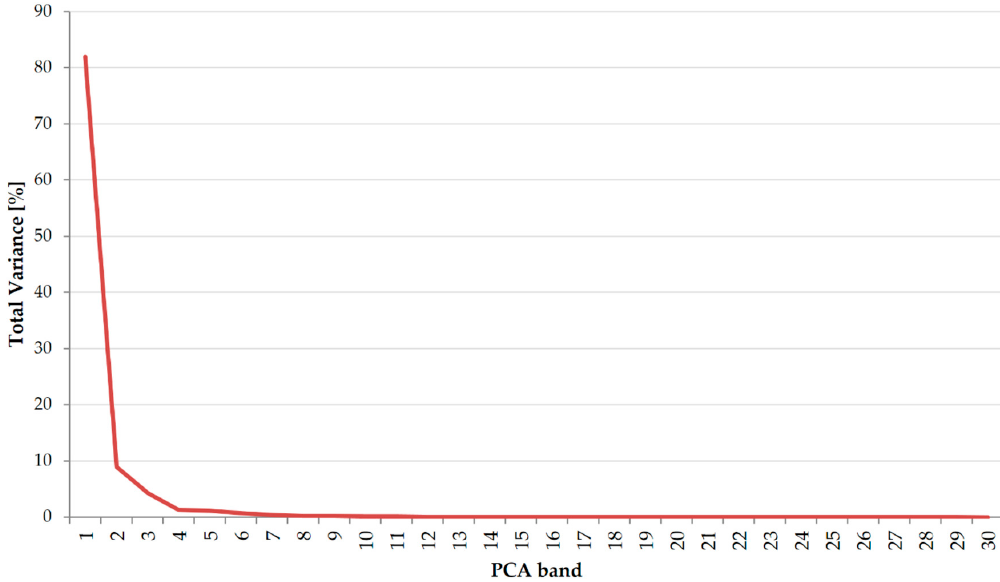
Figure A1. Total variance explained by each PCA band of ABC dataset.